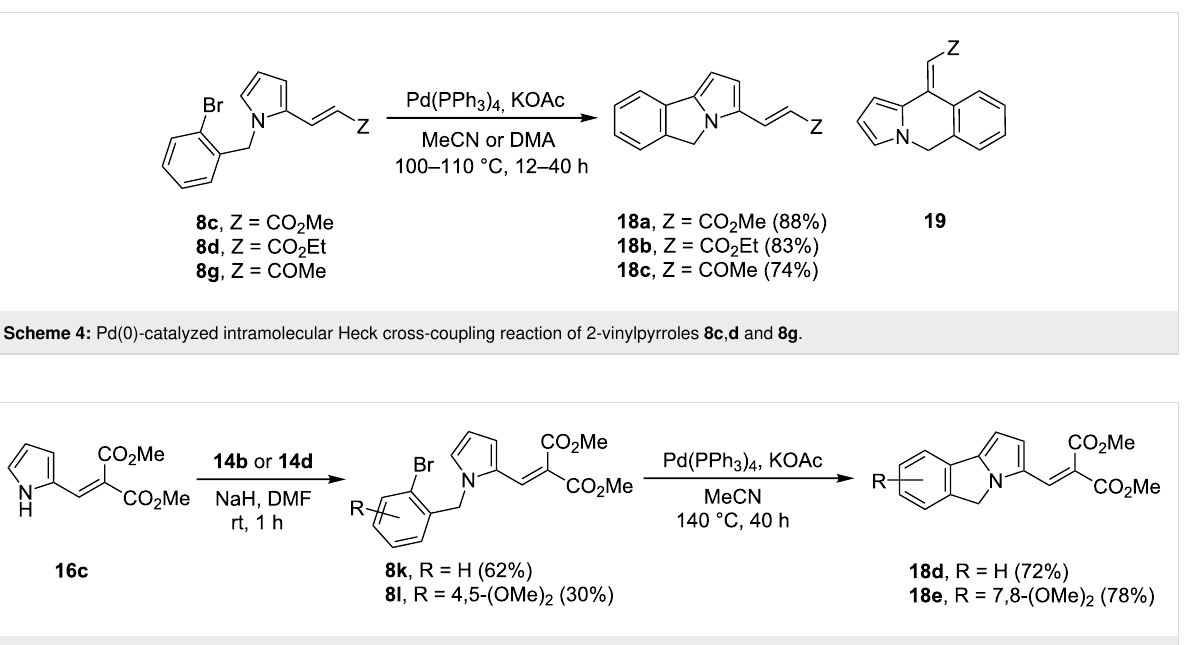
Scheme 5: Synthesis of 2-vinylpyrroles 8k , l and their Pd(0)-catalyzed intramolecular Heck cross-coupling to pyrrolo[2,1- a ]isoindoles 18d , e